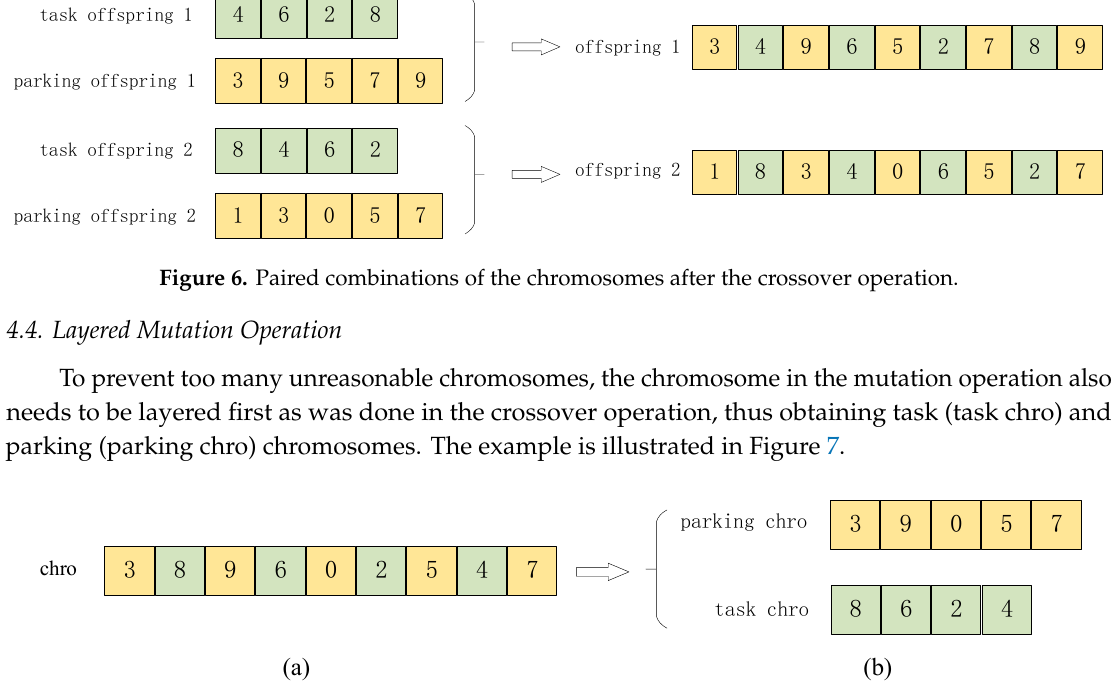
Figure 5. Crossover of the parking chromosomes.